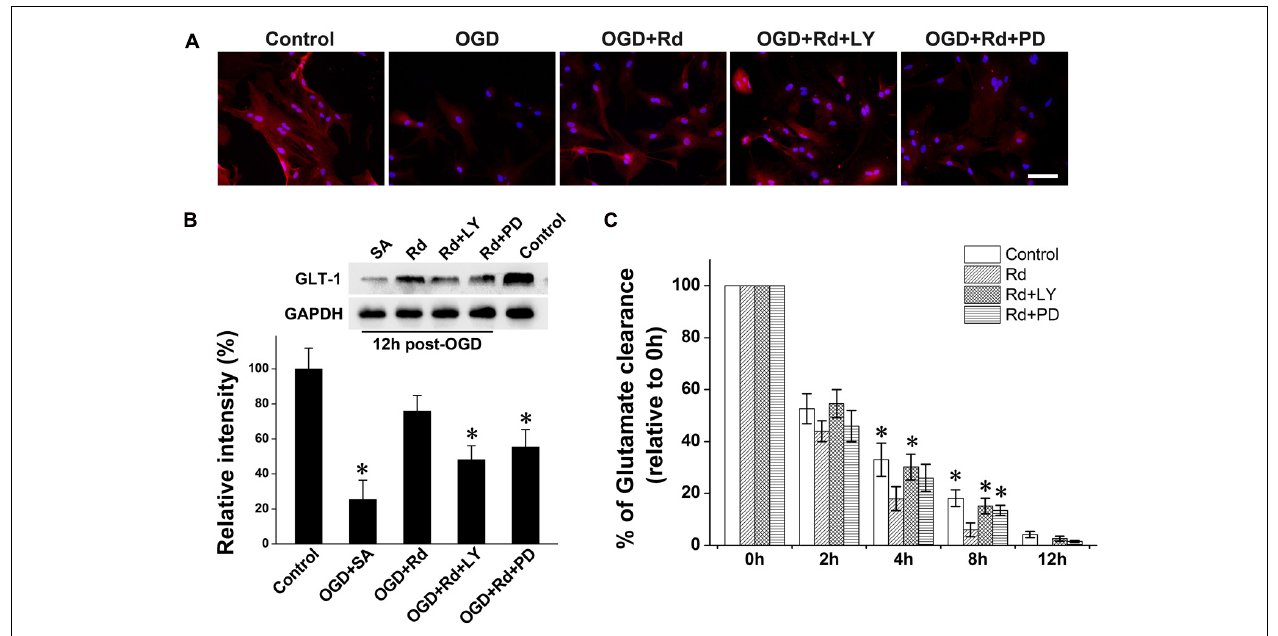
3 h of OGD, 500 μ M glutamate was added to medium, and glutamate concentrations were measured at different time intervals (from 2 to 12 h after OGD washout). Data are expressed as mean ± SEM ( n = 6). Mean values in sham-treated groups were scaled to 100%. * p < 0.05 vs. OGD + Rd